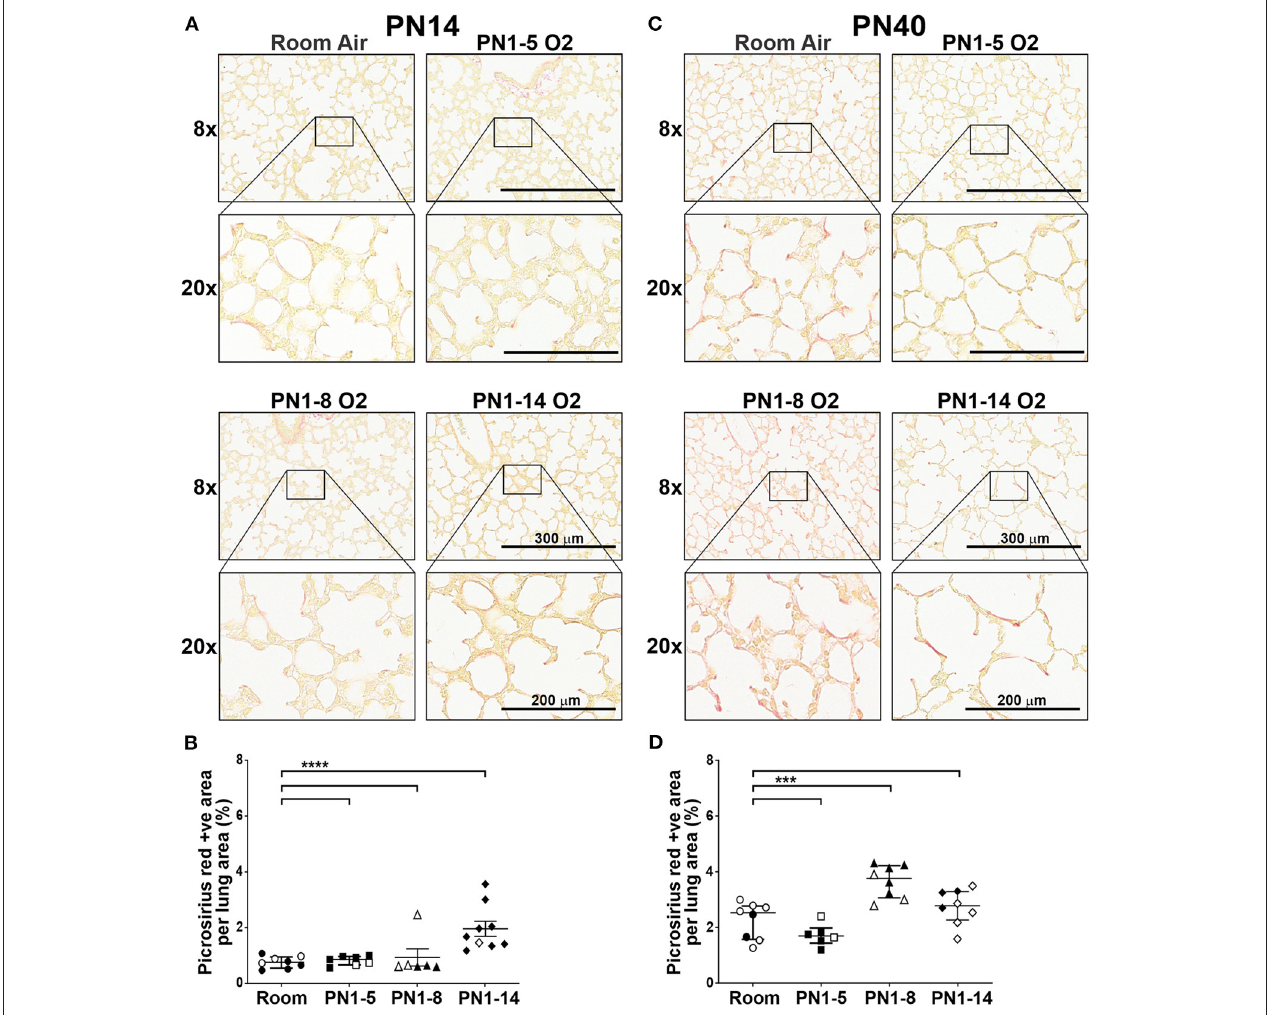
FIGURE 2 | Extensive fibrosis is not a feature of the lungs of neonatal or young adult mice exposed to prolonged supplemental oxygen in early life. C57BL/6 mice were housed in room air or treated from the day of birth with 75% O 2 for 5, 8, or 14 days, then analyzed at PN14 (A,B) or PN40 (C,D) . (A) Representative images of PR-stained cross-sections of lungs at PN14. (B) Proportion of lung tissue of the mice in (A) stained with PR. (C) Representative images of PR-stained cross-sections of lungs at PN40. (D) Proportion of lung tissue of the mice in (C) stained with PR. For (A,C) , images were taken with 8x and 20x objectives using Aperio ScanScope CS; scale bar = 300 and 200 µ m, respectively. For (B,D) , data is presented as median ( µ m) ± IQR. *** P < 0.001, **** P < 0.0001 by Mann-Whitney U -test (2-tailed). n ≥ 6 mice per group, with 2–3L used to analyze each oxygen group in (A,B) , and 1–3L used to analyze each oxygen group in (C,D) . Gender is represented by closed (male) and open symbols (female). PN,